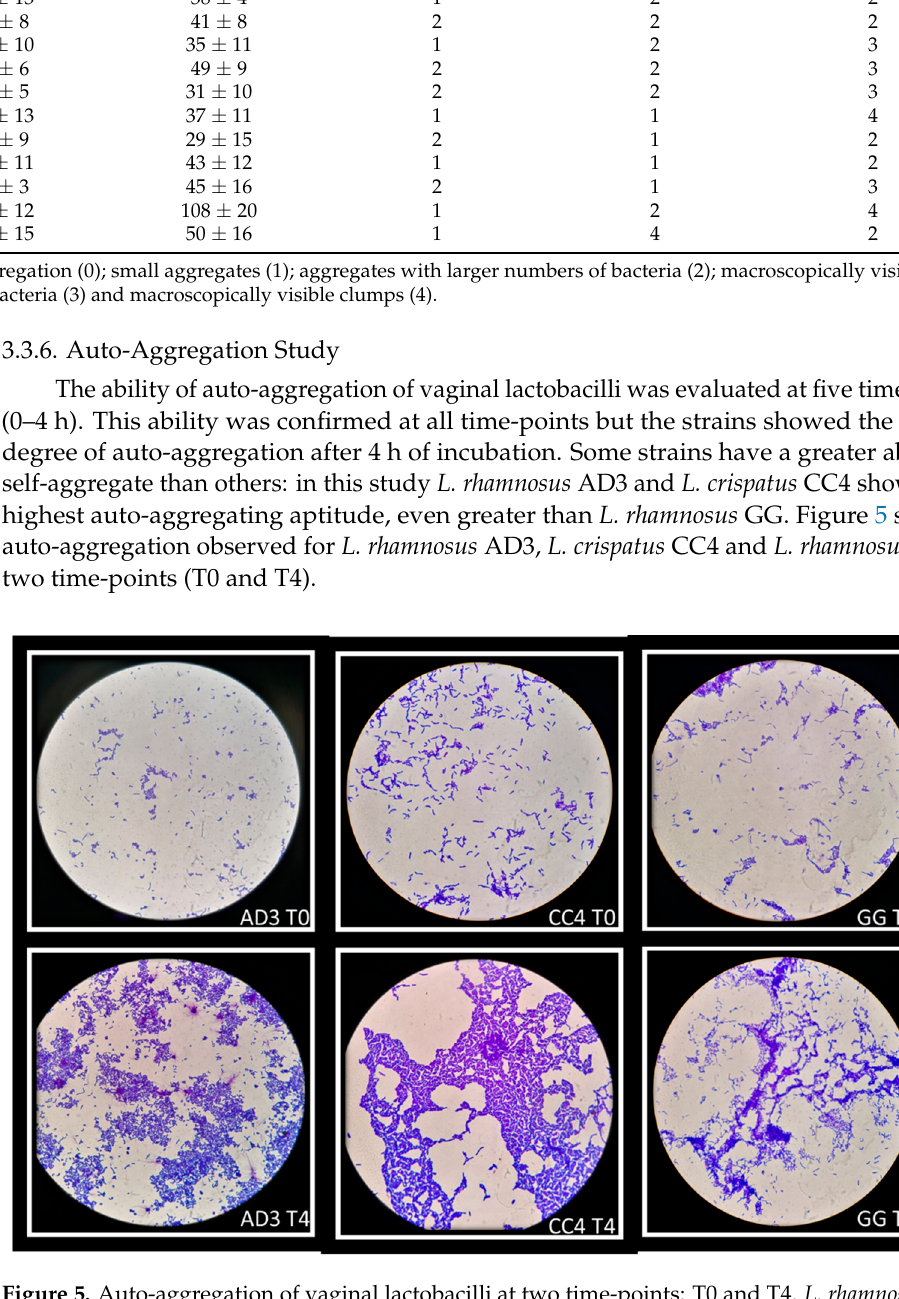
Figure 5. Auto-aggregation of vaginal lactobacilli at two time-points: T0 and T4. L. rhamnosus AD3, L. crispatus CC4 and L. rhamnosus GG showed greater ability to self-aggregate than others strains. Strains were observed under the microscope (1000 × ) after Gram